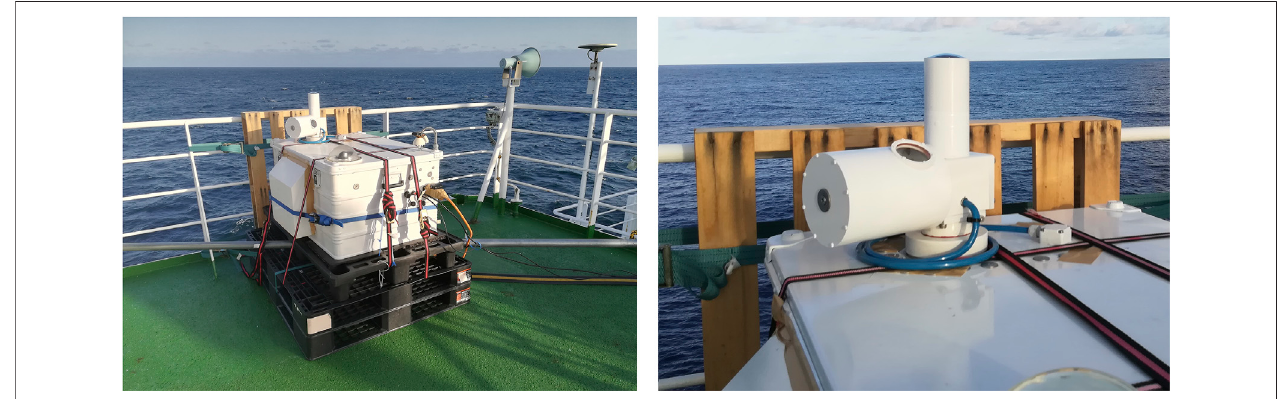
FIGURE2| PhotographsofthemobileEM27/SUNonboardRVMirai(left)withazoomoftheouterpartofthesolartracker(right)showingthelensmountofthe fi sh- eye camera (vertical tube) and the entrance window for the solar beam.